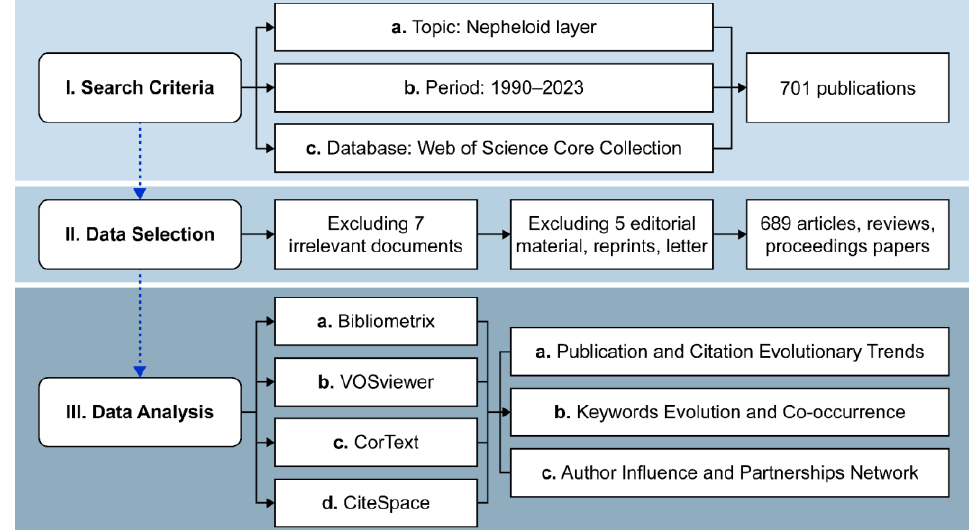
Figure 2. Paper selection process and flow chart framework for the bibliometric analysis using Web of Science.